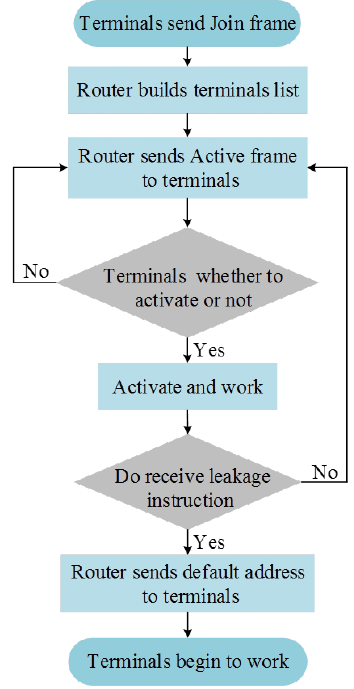
Figure 4. Flowchart of the ZigBee network leakage triggered